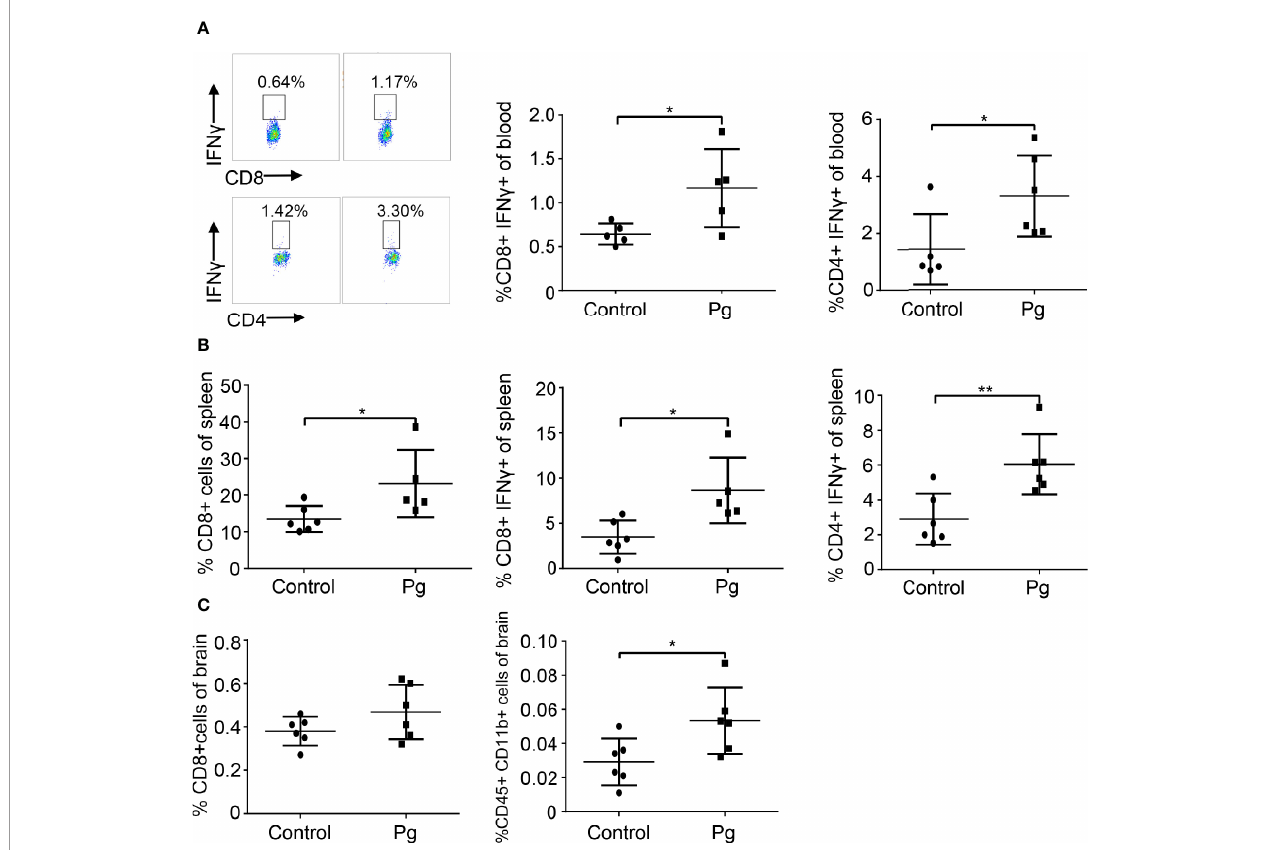
FIGURE 3 | Pg-administered mice show changes in proportions of periphery lymphocytes and brain-in fi ltrating immune cell subsets. (A) Flow cytometry is used to analyze the composition of blood cells in the control and Pg-administered group. Numbers represent the percentage of the target cell group in blood cells. (B) Flow cytometry is used to analyze the composition of spleen cells. (C) Flow cytometry is used to analyze the composition of brain-in fi ltrating immune cells. Each dot represents data from a mouse. Data were shown as means ± SEM. *p ≤ 0.05; **p ≤